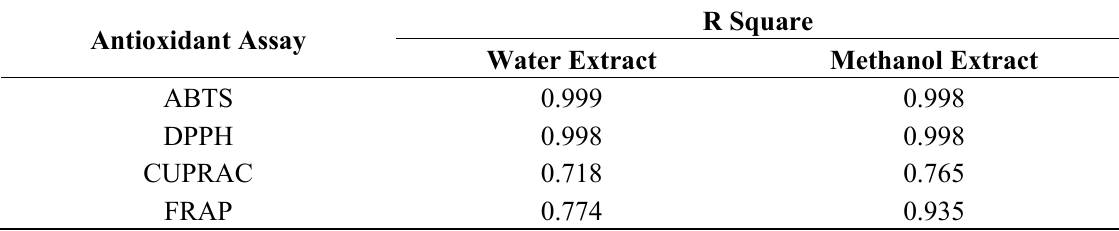
Table 5. Correlation analysis of TPC and antioxidant capacity for each E . tirucalli extract. Antioxidant